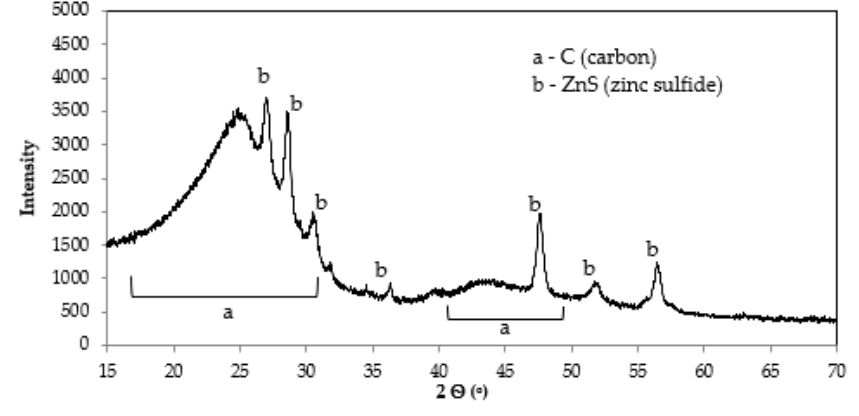
Figure 3. The XRD pattern of ST char.